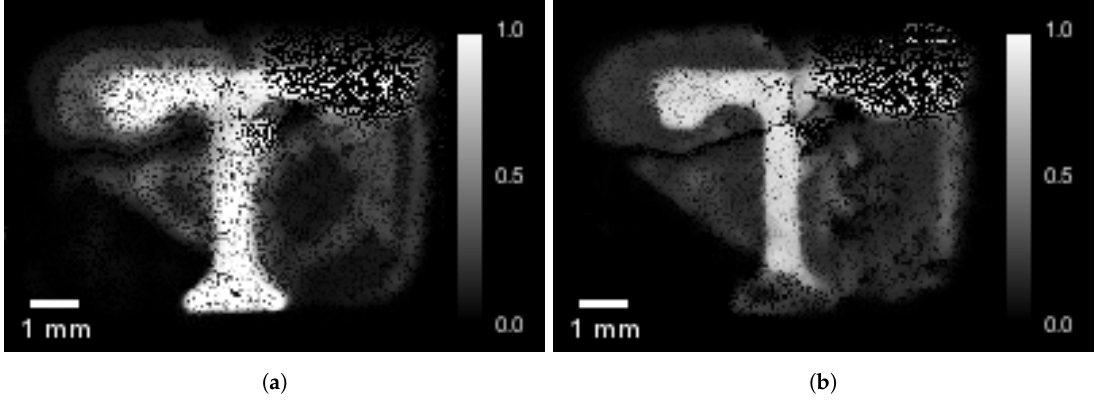
Figure 12. Neutron image of 3D printed “Power T”. ( a ) threshold: +4 mV; ( b ) threshold: +24